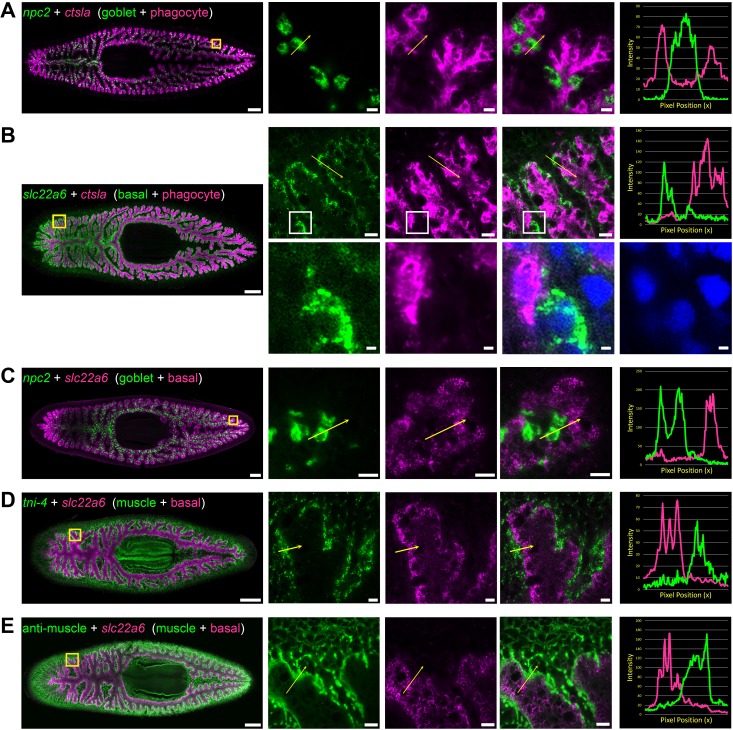
Double fluorescence in situ hybridization reveals three major cell types in the planarian intestine.(A) Confocal images of npc2 (green) and ctsla (magenta) in situ hybridization. Left to right, whole animal (yellow box indicates magnified region in right panels), zoomed area in green, magenta, and merge (yellow arrow indicates profile line in right-most panel), and a graph showing pixel intensity in each color from tail to head of the yellow profile arrow. ctsla is the top phagocyte-specific gene in the phagocyte microarray dataset, while npc2 is enriched in goblet cells. (B) slc22a6 (green) and ctsla (magenta). slc22a6 mRNA is restricted to the basal region of the intestine, and shows minimal overlap with the phagocyte marker ctsla. The white box represents the cropped region shown below with DAPI labeling nuclei, indicating that these riboprobes label distinct cells. (C) npc2 (green) and slc22a6 (magenta). npc2 is enriched in goblet cells while slc22a6 is enriched in basal cells, with minimal overlapping signal. (D) troponin I 4 (tni-4, green) (Witchley et al., 2013) and slc22a6 (magenta). tni-4 is expressed by visceral muscles, while slc22a6 is found in basal cells. (E) Anti-muscle antibody (6G10, green) and slc22a6 (magenta). Detailed gene ID information is available in Supplementary file 1 and in Results. Scale bars, whole animals 200 μm; magnified images, 10 µm, magnified crop of basal cell (B), 2 µm.